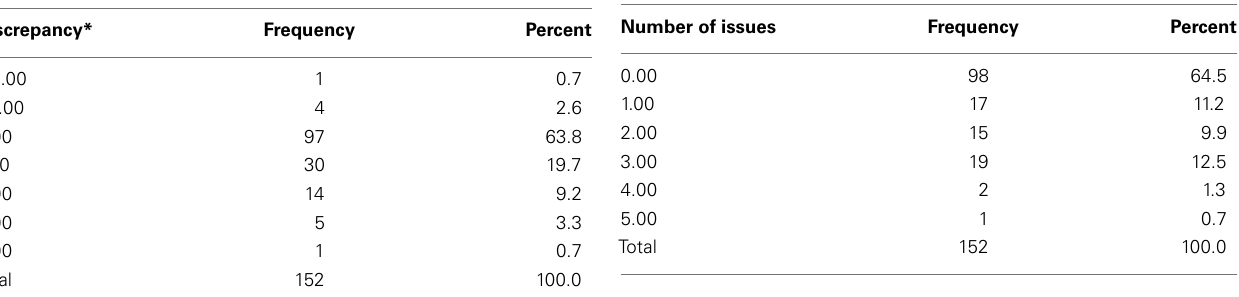
Table 4 | Number of issues encountered during the IVR Digit Span Forward